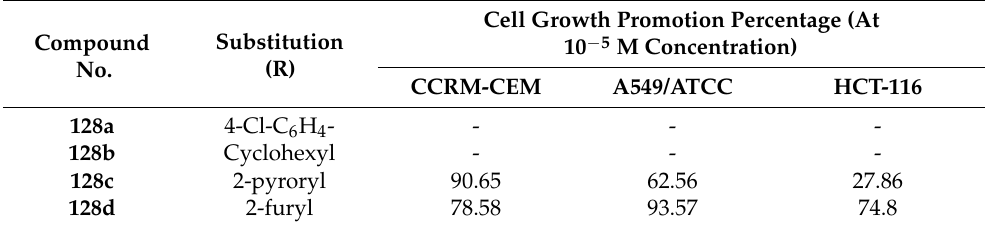
Abdelaal et al. (2021) synthesized quinazoline ‐ pyrazole hybrids as potential antipro ‐ liferative agents. The newly synthesized compounds showed activity against hepatocel ‐ lular carcinoma (liver) HEPG2, mammary gland (breast) MCF ‐ 7 and colon cancer HCT ‐ 116 cells. The structure of quinazoline ‐ pyrazole hybrids is given in Figure 122 and the in vitro IC 50 of compounds ( 129 – 133 ) against cancer cell lines is shown in Table 109 [200].